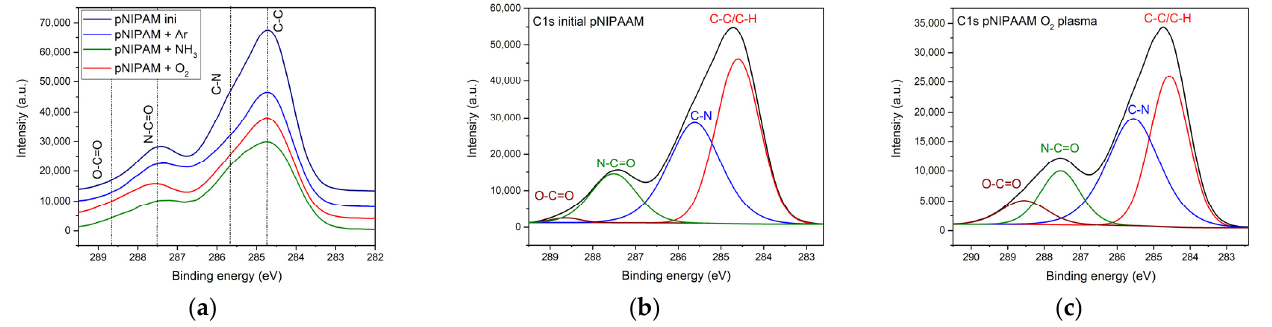
Figure 5. ( a ) Comparative high-resolution C1s spectra for various gases plasma treatment; ( b ) high-resolution spectrum of C1s binding energy region for the initial pNIPAAM; ( c ) high-resolution spectrum of C1s binding energy region in the case of oxygen plasma